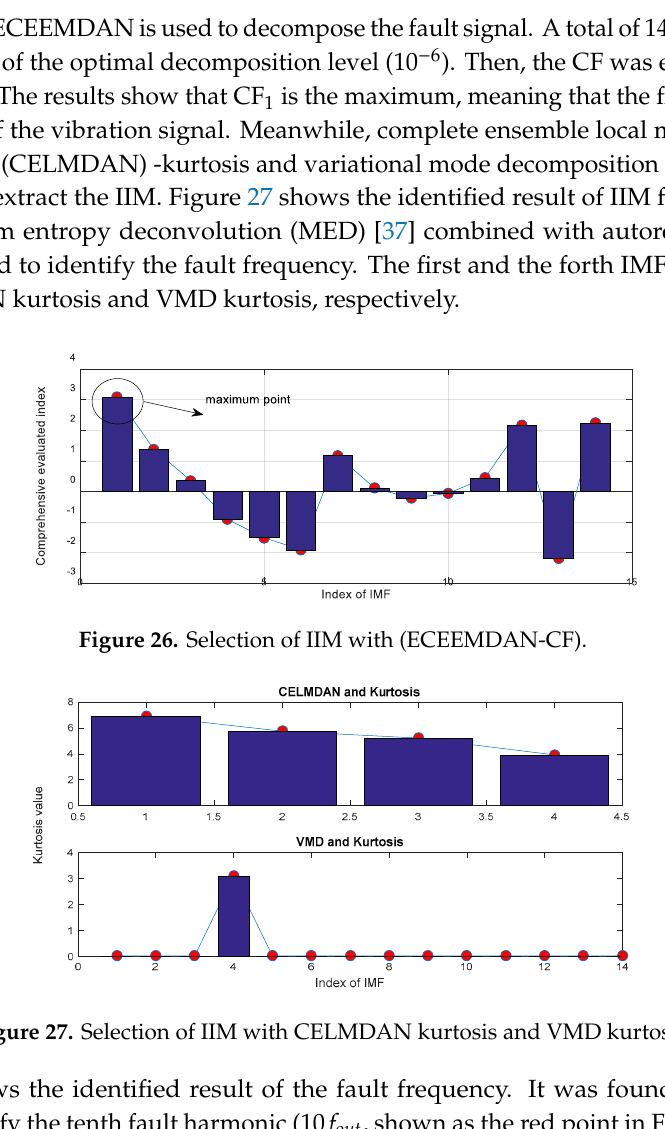
Figure 25. Comparison of computational cost for ECEEMDAN and CEEMDAN.